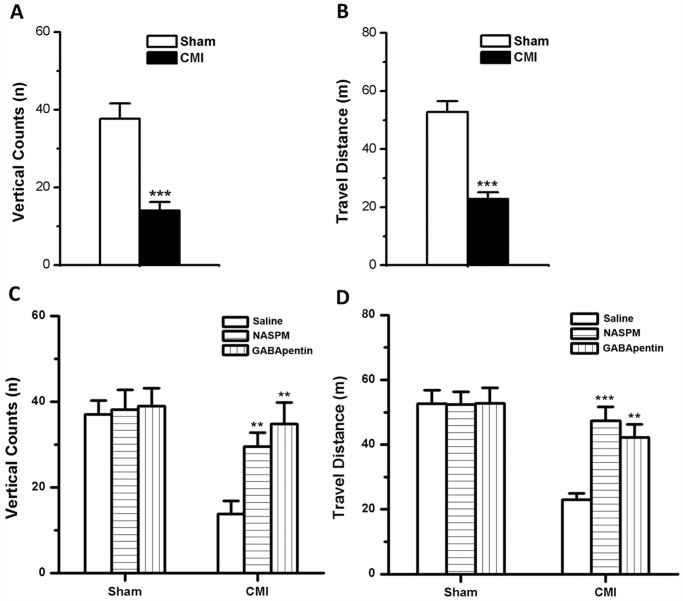
Behavioral assessment of rats in the open field.(A-B) Vertical counts (A) and travel distance (B) were decreased in rats with CMI. ***, p < 0.001 compared with the sham group. (C-D) Microinjection of NASPM or GABApentin into the SolC significantly increased the vertical counts (C) and travel distance (D) in CMI rats. **, p < 0.01; ***, p < 0.001 compared with the CMI group with saline microinjection.